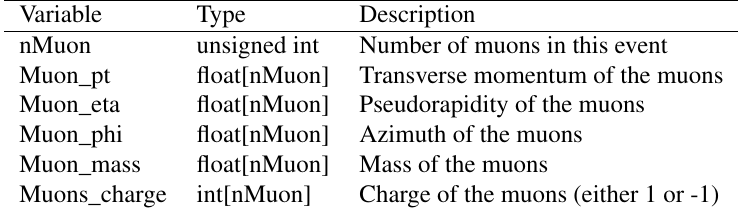
Table 1. Data-format of a muon collection in the NanoAOD format